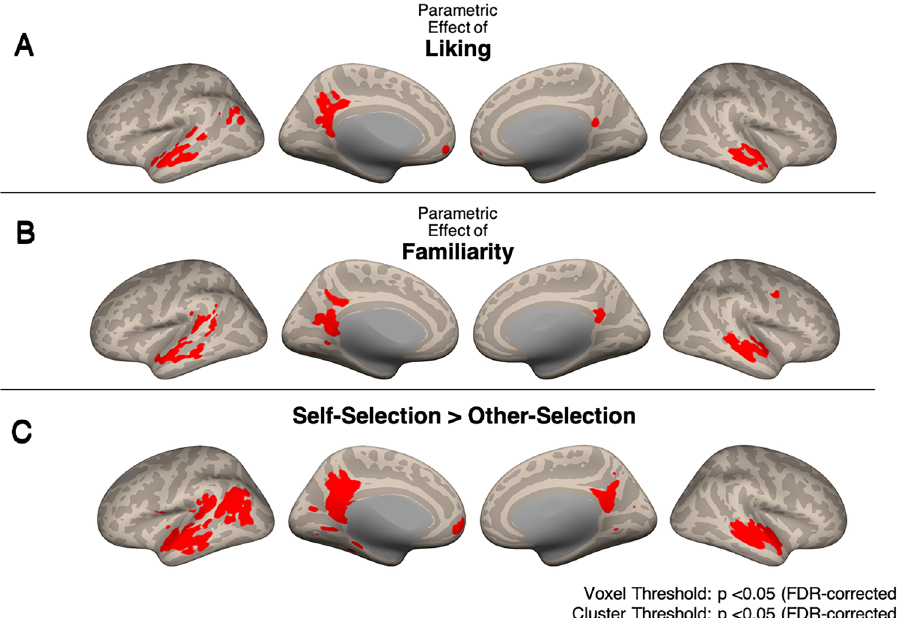
Figure 2. Conjunction analysis of pre- and post-intervention univariate whole-brain results. ( A ) Parametric effects of liking. Auditory (STG, STS, MTG), reward and DMN (mPFC and PCC) regions showed activity that varied parametrically with liking ratings. ( B ) Parametric effects of familiarity. Auditory and DMN regions showed activity that also varied parametrically with familiarity ratings. ( C ) Self-selected > Other-selected music. Greater widespread engagement was observed in auditory, reward, and DMN regions for self-selected music compared to other-selected music. All images are results of second-level analyses showing significant clusters at the p < 0.05 FDR-corrected level.